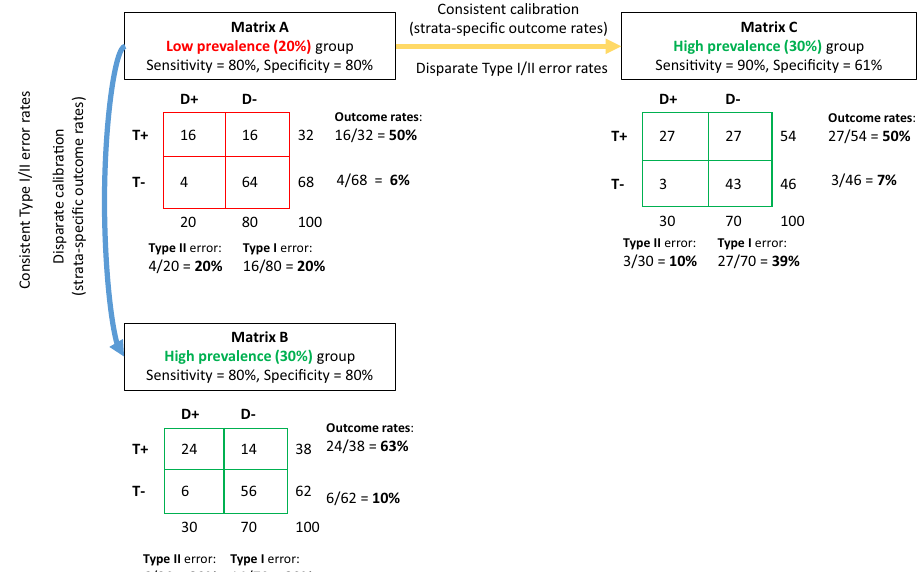
Fig. 1 Mutual incompatibility of fairness criteria. For two groups with different outcome rates, a predictive test can have consistent error rates or consistent calibration but not both. We present outcomes using coarsened prediction scores, thresholded to divide the population ( N = 100) into low and high risk strata. Confusion matrices for a low prevalence group with a 20% outcome rate (Matrix A, red) and a high prevalence group with a 30% outcome rate (Matrices B and C, green) are shown. For the low prevalence group, a predictive test with an 80% sensitivity and speci fi city identi fi es a high risk (test + ) strata with an outcome rate of 50% (i.e., the positive predictive value) and a low risk (test − ) strata with an outcome rate of ~6% (i.e., the false omission rate). However, as shown in Matrix B, the same sensitivity and speci fi city in the higher prevalence group gives rise to outcome rates of ~63% and ~10% in the high and low risk-strata, respectively. This violates the criterion of test fairness, since the meaning of a positive or negative test differs across the two groups. Holding risk-strata speci fi c outcome rates constant would require a higher sensitivity and lower speci fi city (Matrix C). This violates the fairness criteria of equalized error rates. For example, the Type I error rate (i.e., the false positive rate) would almost double from 20% in the low prevalence population to ~39% in the higher prevalence population. The diagnostic odds ratio was fi xed at ~16 across this example, whole numbers are used to ease